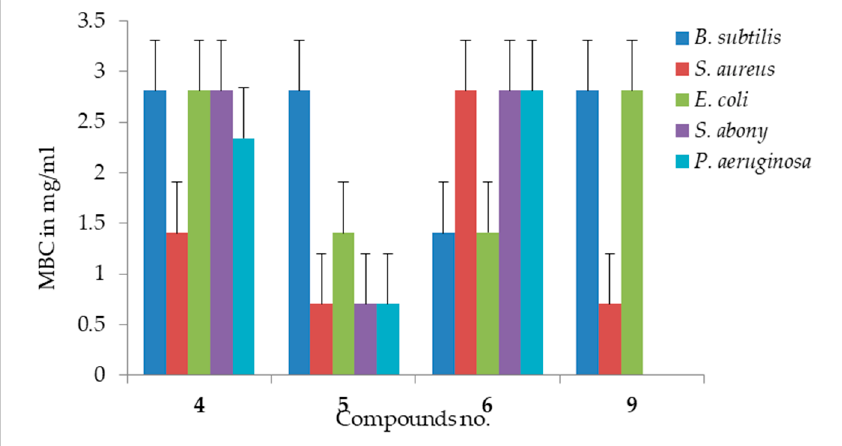
Figure 2. MBC values of some compounds against tested organisms.